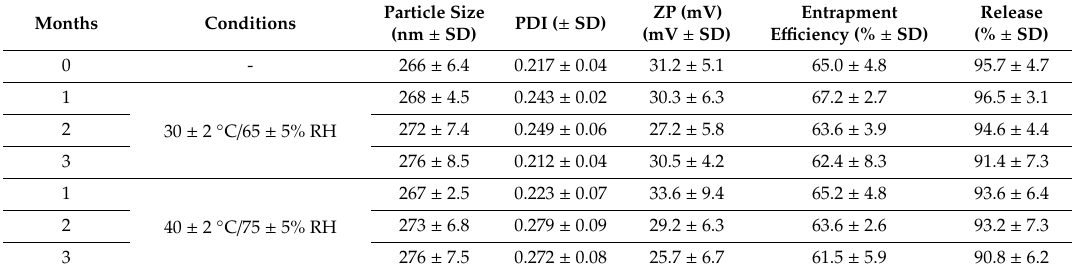
Table 2. Stability data of optimized ELX loaded SLNs (F2).